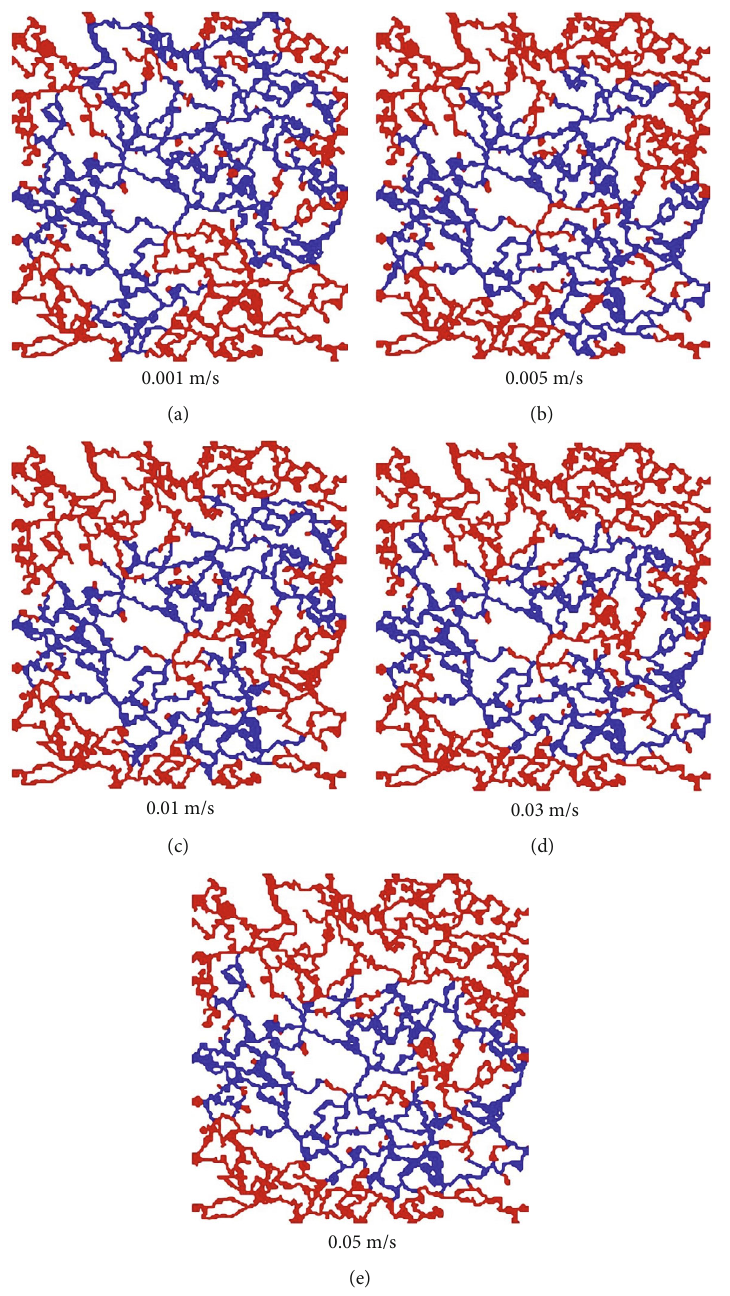
Figure 6: Oil and water two-phase distribution versus injection velocity. (a)0.001 m/s. (b)0.005 m/s. (c)0.01m/s. (d)0.03 m/s. (e)0.05